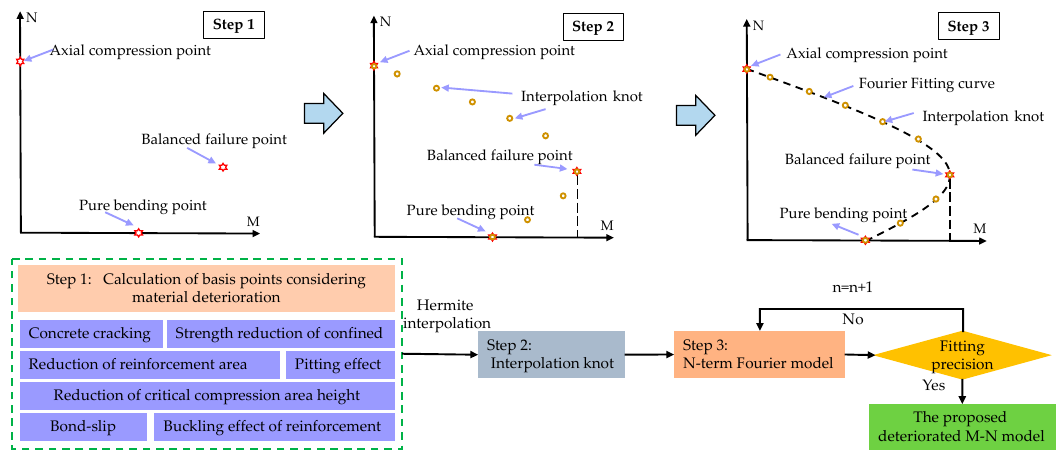
Figure 2. The flowchart of the proposed method.